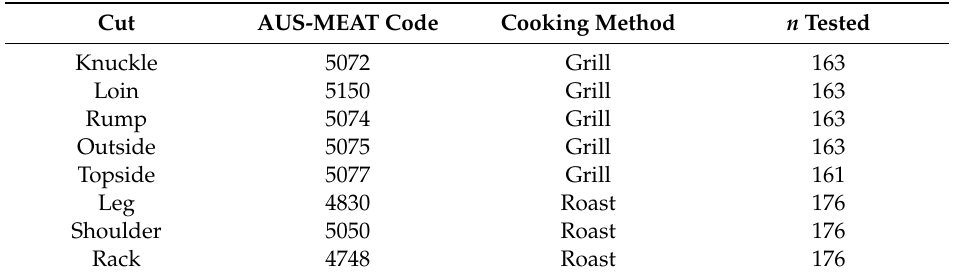
Table 2. Number and type of cuts collected and eaten by consumers according to cooking